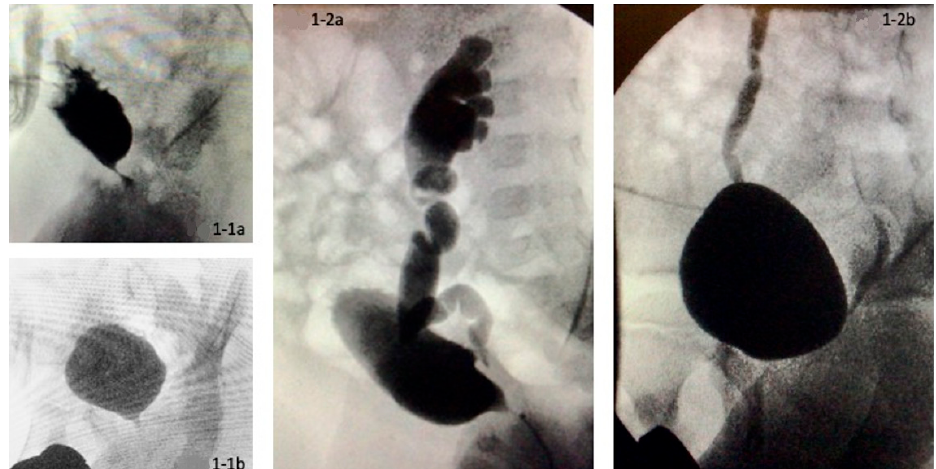
Figure 1. Pre- and postoperative voiding cystourethrograms of two patients (1-1a,1-2a). Preopera- tively severely trabeculated bladder and vesicoureteral reflux (1-1b,1-2b). Normalization of bladder configuration and decrease in vesicoureteral reflux at 1-year follow-up.